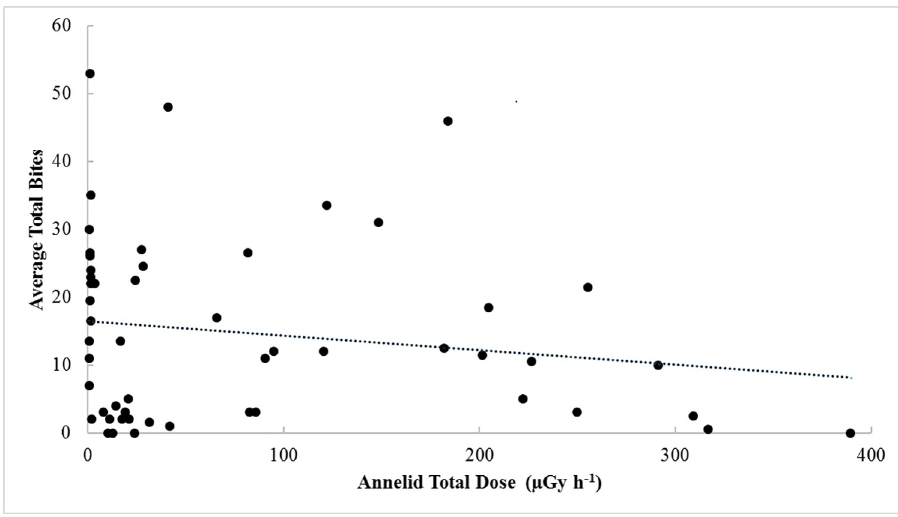
Fig 2. A comparison of feeding activity (total bites) and estimated absorbed dose rate for